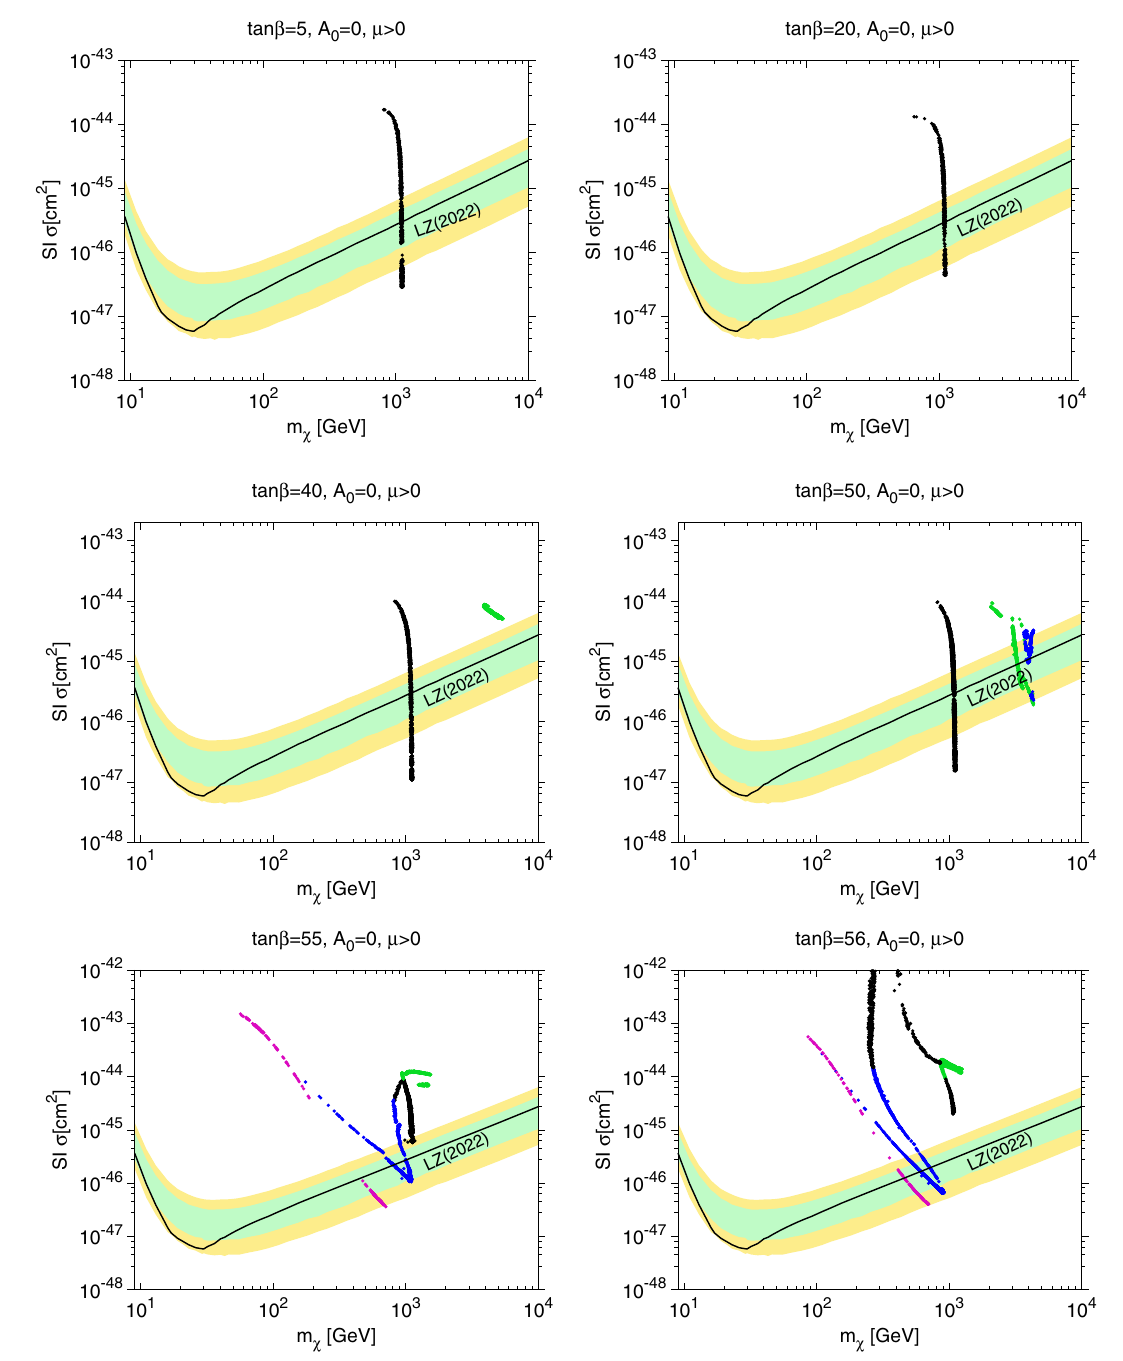
Fig. 9 Calculations of spin-independent WIMP-nucleon scattering for points along the dark matter strips for tan β = 5 , 20 , 40 , 50 , 55 and 56 with A 0 = 0 and μ > 0 compared with the LUX-ZEPLIN upper limit (solid black line). The green and yellow bands are the 1 σ and 2 σ LZ